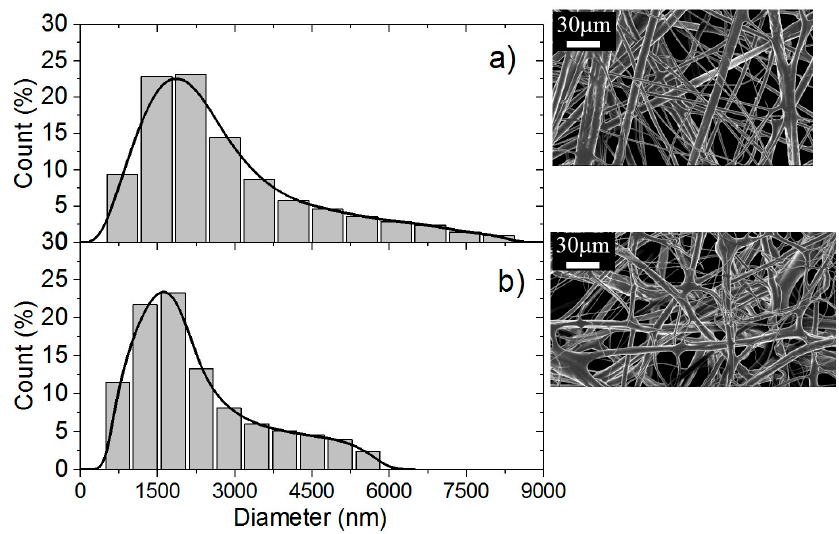
Figure 10. Diameter distribution of chitosan/PEO fibers expressed as a function of the count of fibers in % for PEO M W = 5 × 10 6 at the concentration of ( a ) 5% and ( b ) 3%.